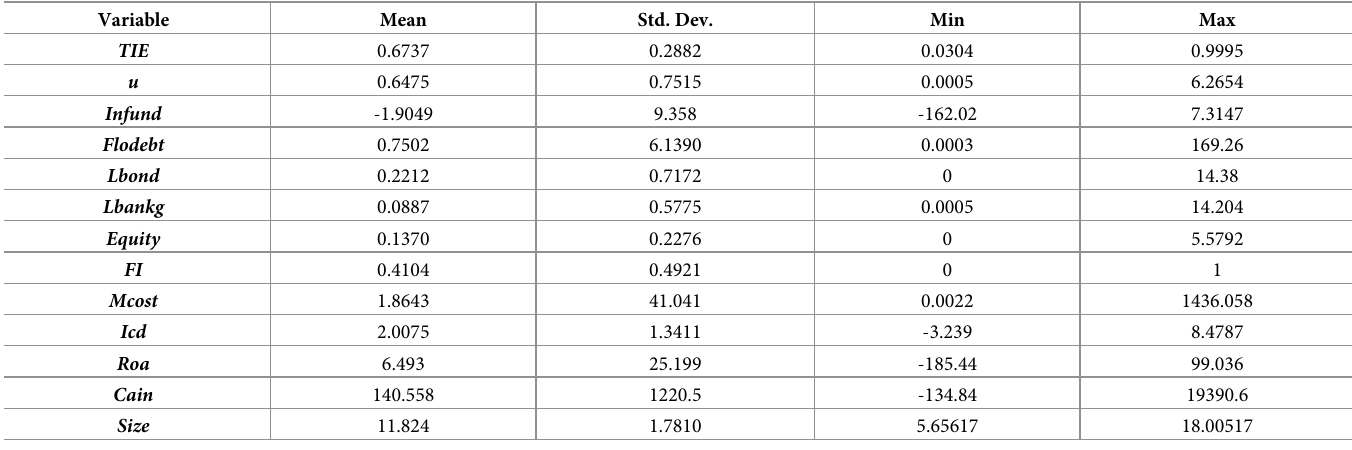
Table 7. Descriptive statistics of